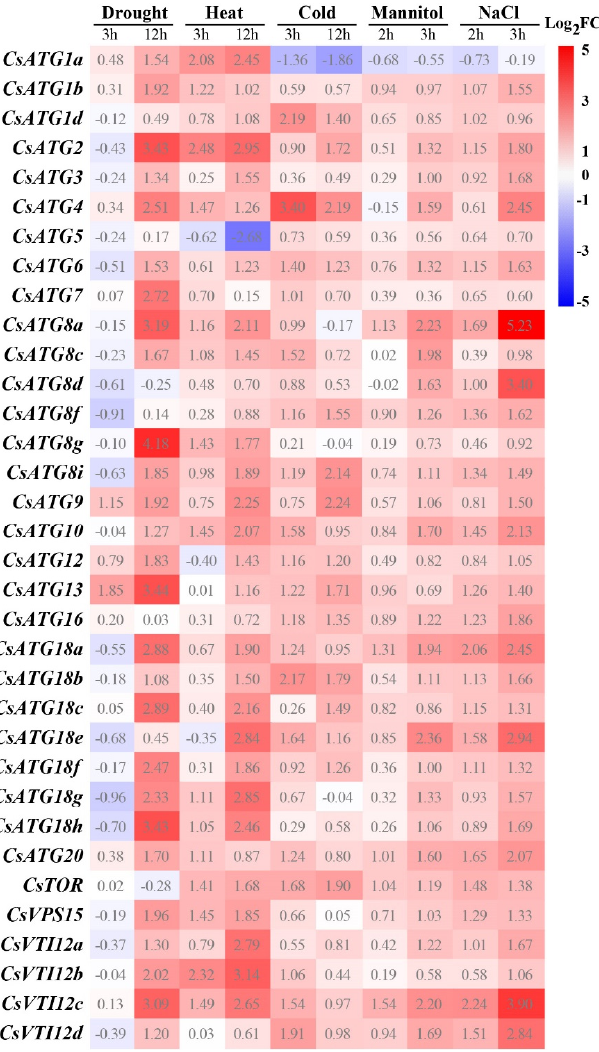
Figure 4. Expression patterns of CsATG genes under drought, heat, cold, mannitol, and salt stresses. qRT-PCR was used to determine the relative expression levels of CsATGs in the leaves of sweet orange treated with drought, heat (42°C), cold (4°C), mannitol (400 mM), and NaCl (200 mM) stresses. Leaves sampled from plants under normal conditions were used as controls (CK). The fold change (FC) was calculated as (relative expression of CsATGs under treatments)/(relative expression of CsATGs in the CK). The R package was used to generate the heat map based on the mean log 2 FC values of three biological replicates.